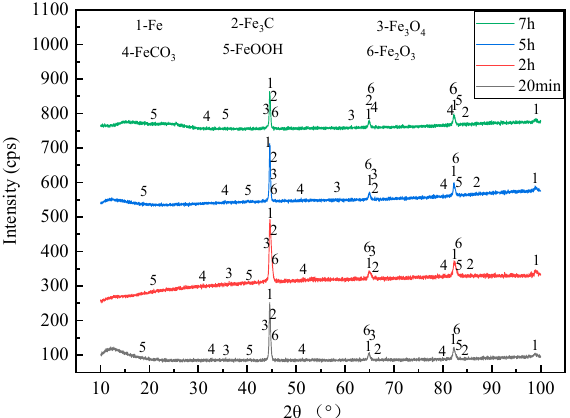
Figure 7. The XRD pattern of the corrosion products at 0.1 MPa CO 2 pressure under different corrosion time conditions.